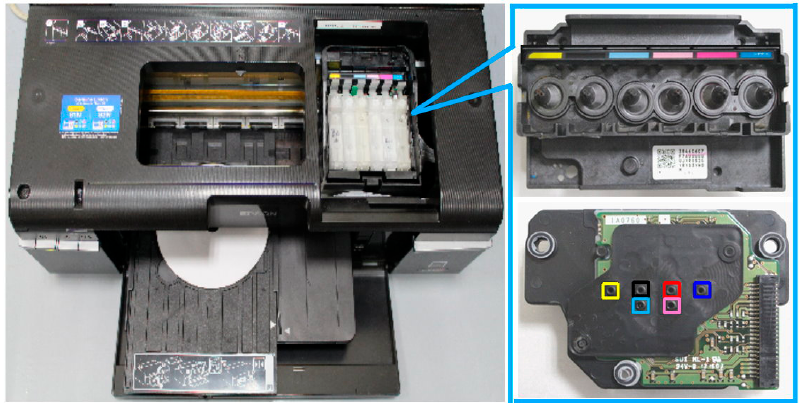
Figure 2. Epson T50 printer with six color channels.